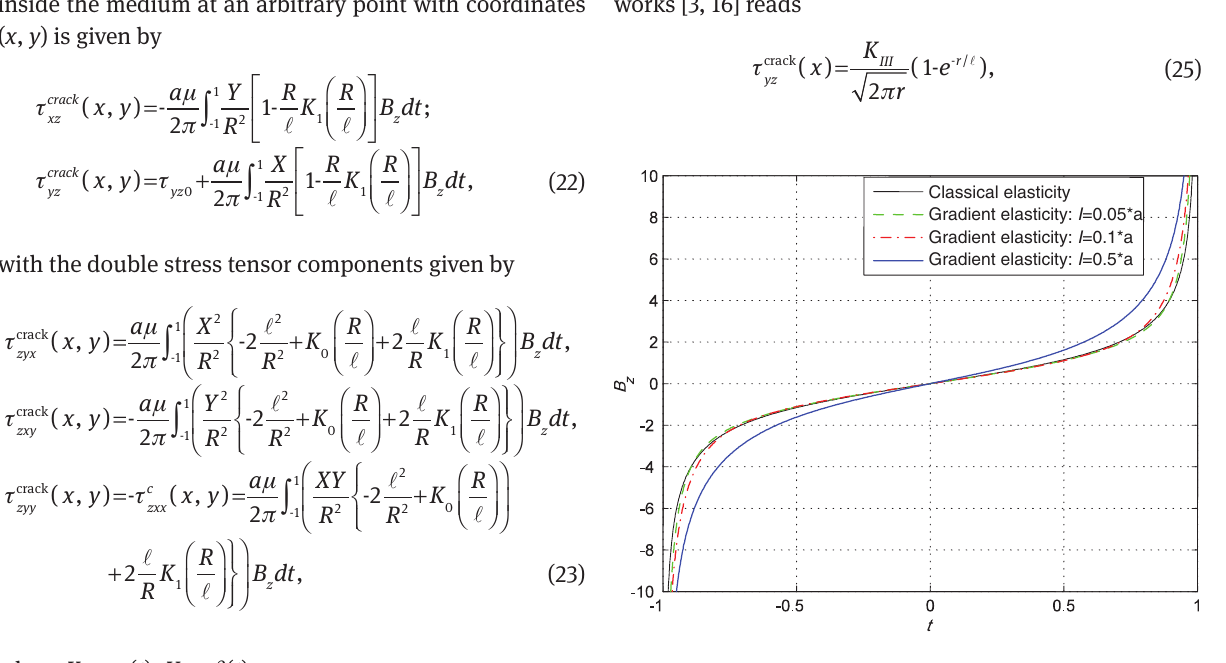
Figure 2: Dislocation density of a